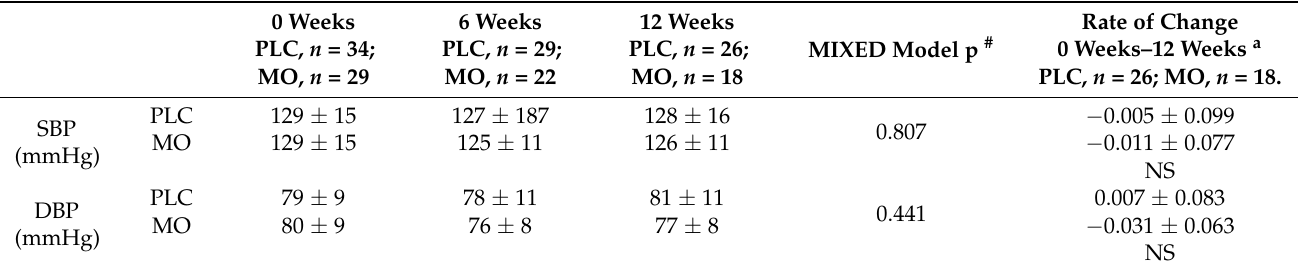
Table 5. Systolic and diastolic blood pressure in patients with prediabetes of the PLC and MO groups during the intervention.